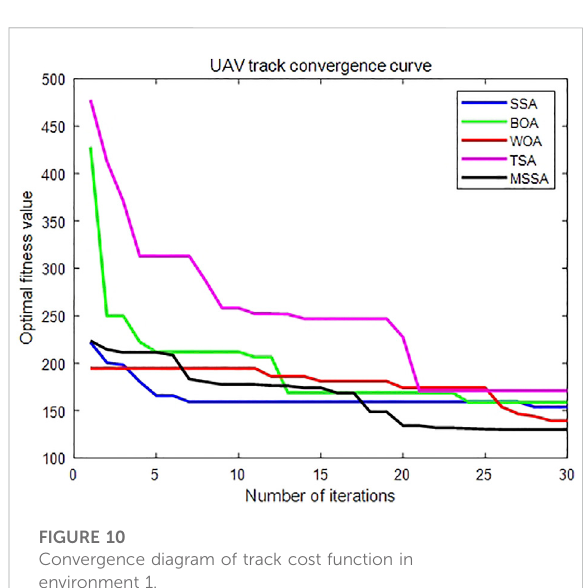
FIGURE 10 Convergence diagram of track cost function in environment